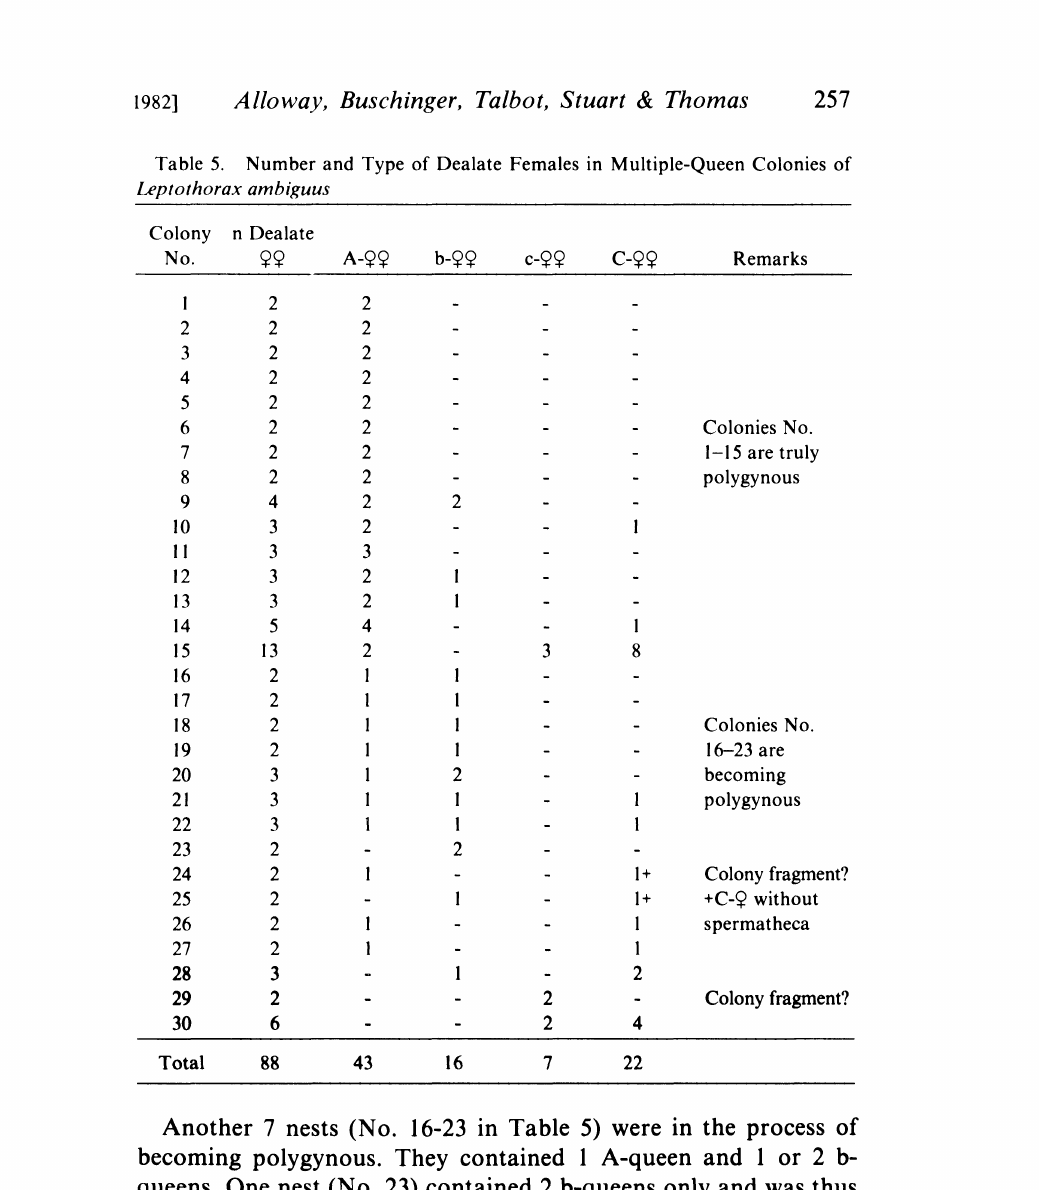
Table 5. Number and Type of Dealate Females in Multiple-Queen Colonies of Leptothorax ambiguus Colony n Dealate